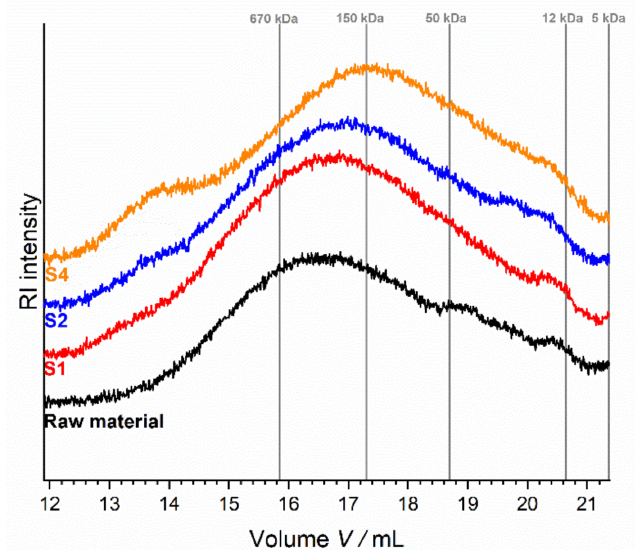
Figure 4. Molecular weight distribution of soluble dietary fiber (SDF) of enzymatically treated apple pomace (raw and extruded) as determined by using HPLC with refractive index (RI) detection. Dextrans of defined molecular weight were used for calibration (grey lines). S1: only transport elements, S2: two reverse elements, S4: two reverse elements and a kneading